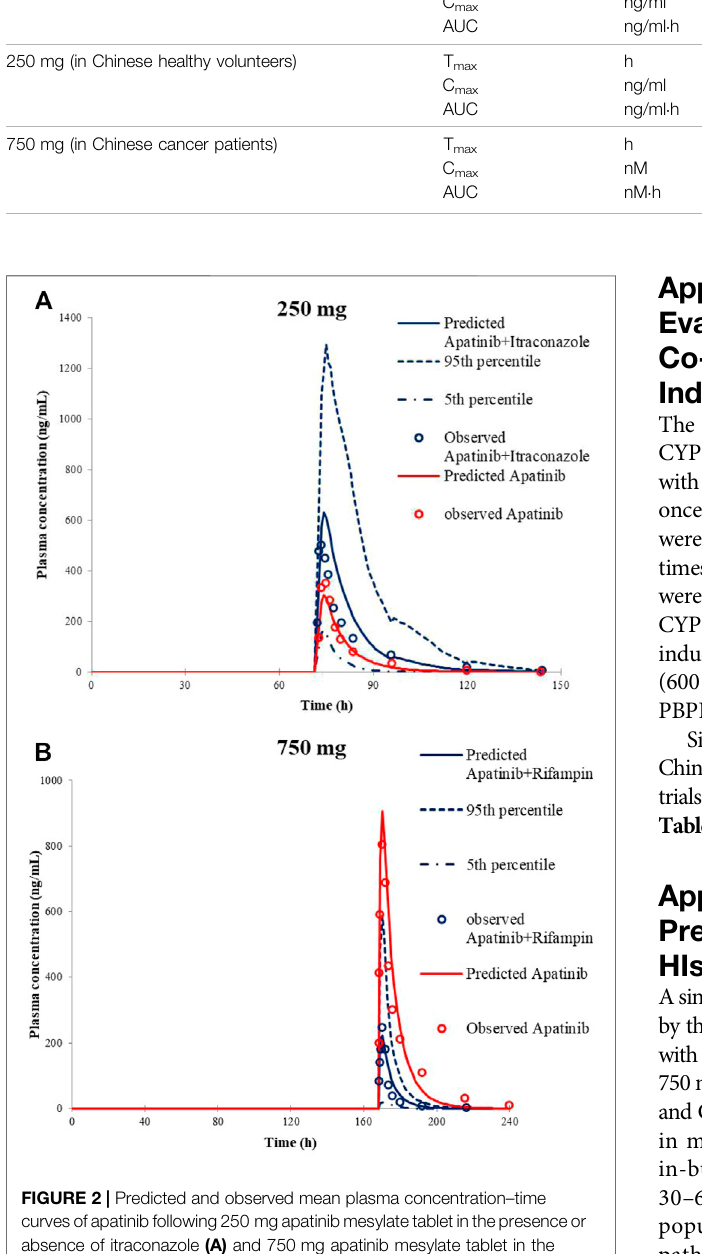
absence of itraconazole (A) and 750 mg apatinib mesylate tablet in the presence or absence of rifampin (B) .